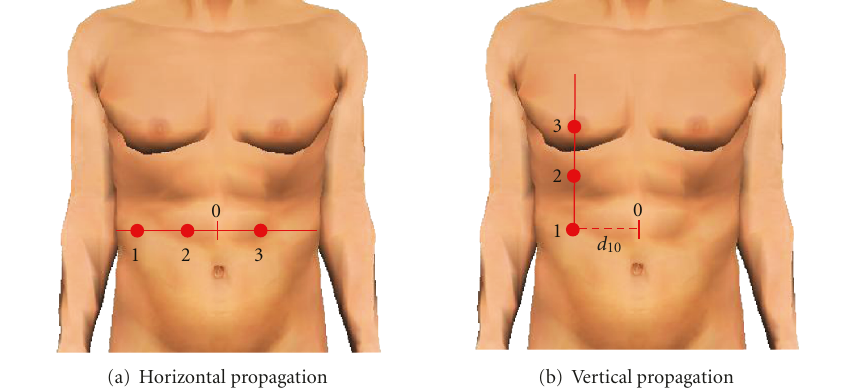
Figure 10: Two dimensions of propagation in the normal polarization scenario.